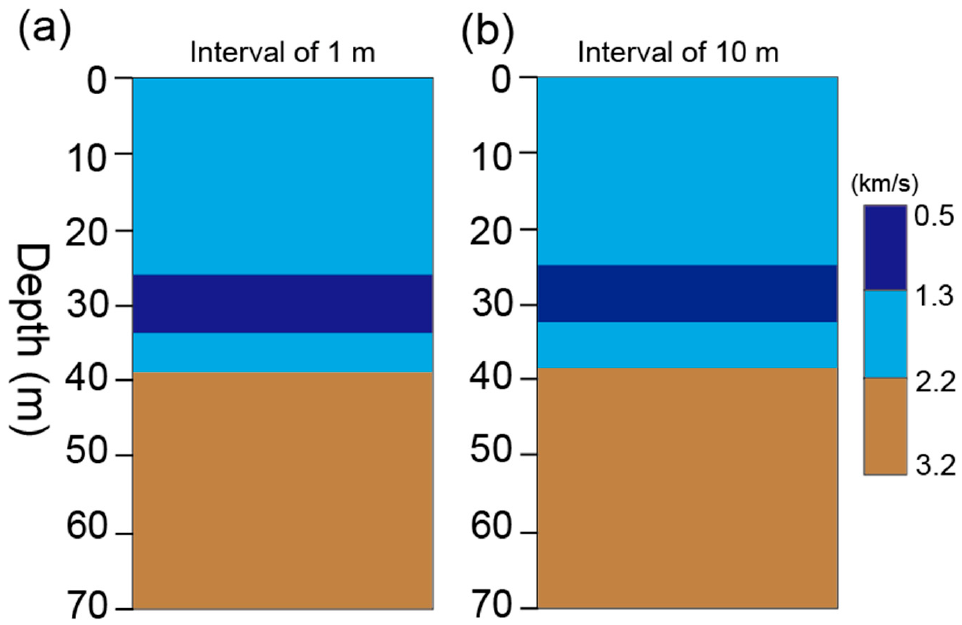
Figure 6. Estimated S wave velocity structure of the KQGR Glacier based on the seismograms from the 16 seismometers with intervals of 1 m ( a ) and 10 m ( b ).